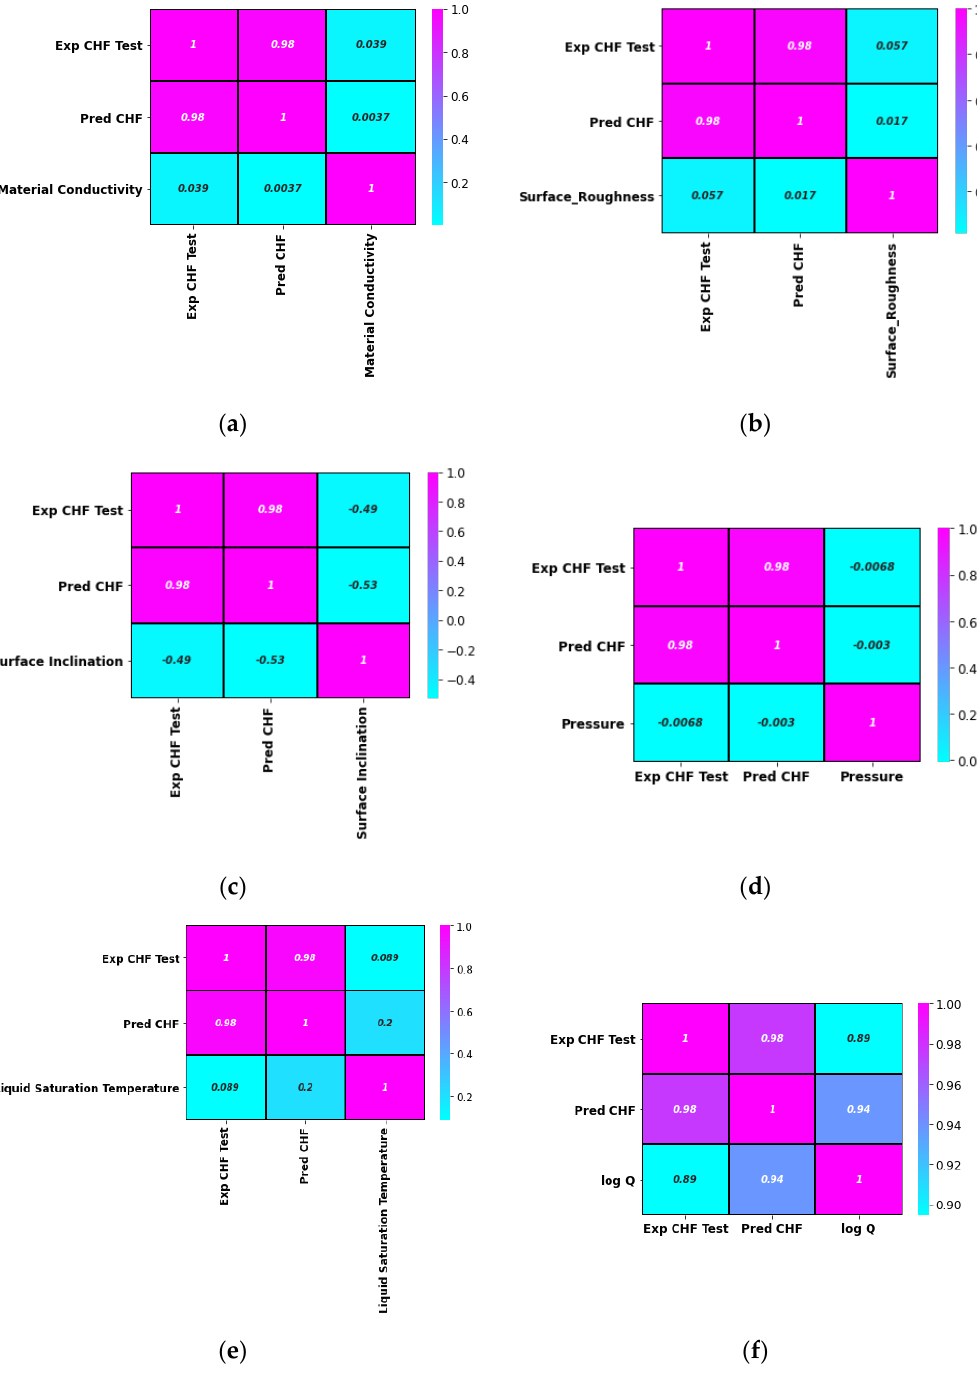
Figure 14. Heat map comparison plots to assess the actual and projected data of the CHF with respect to the input parameters: ( a ) material conductivity, ( b ) surface roughness, ( c ) surface inclination, ( d ) pressure, ( e ) liquid saturation temperature, and ( f ) heat flux.